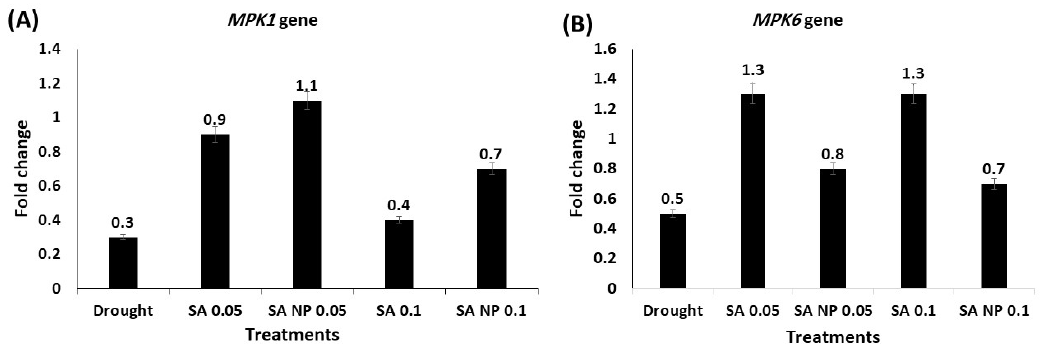
Figure 5. The effect of SANPs and bulk SA at 0.05 and 0.1 mM as a foliar application on the expression profiling of drought-tolerance related genes in Catharanthus roseus leaves of treated plants using qRT-PCR analysis. ( A ) MPK1 gene; ( B ) MPK6 gene. Data were normalized using the Actin gene (MG813871.1) as an internal reference gene. Error bars represent standard errors.